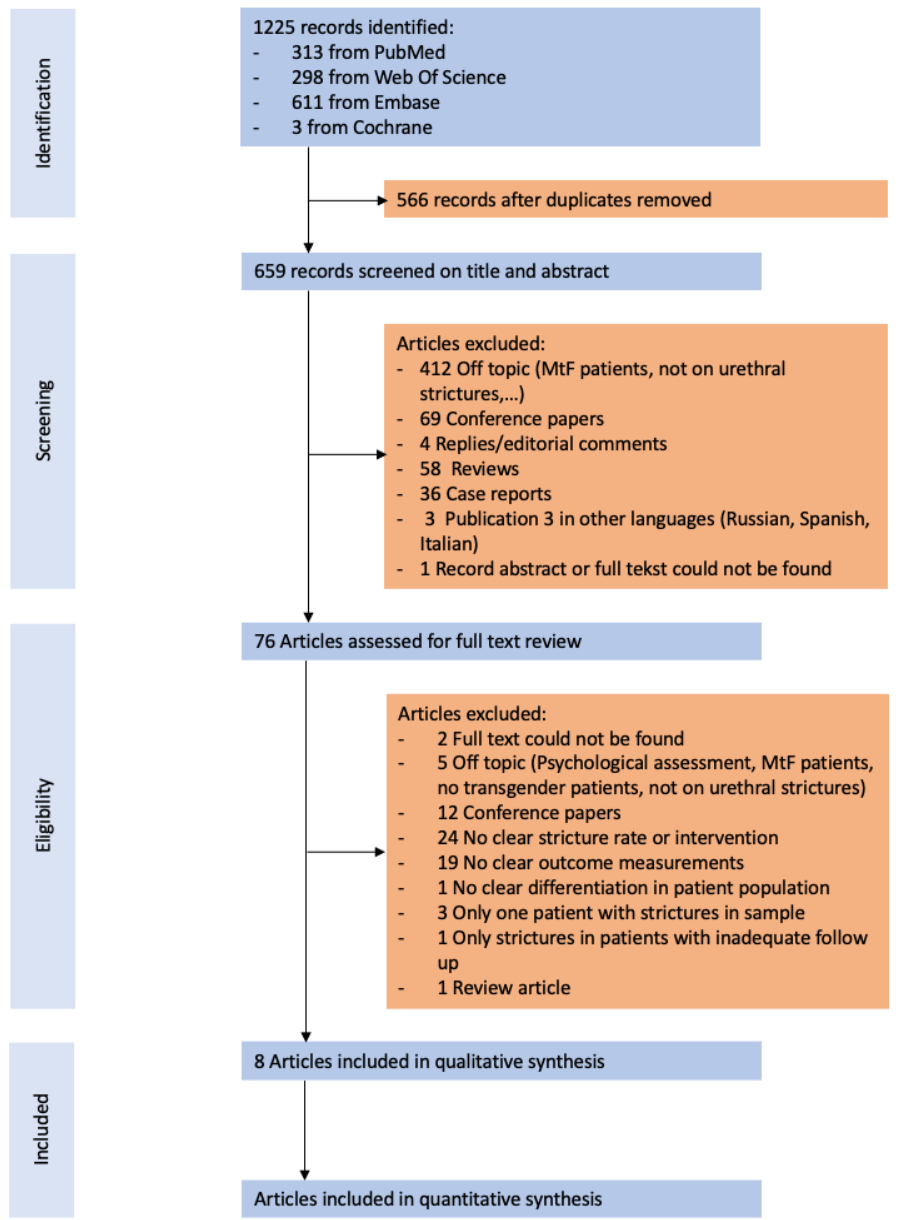
Figure 1. PRISMA flow diagram for study selection. Table 1. Summary characteristics and risk of bias of included studies. FtM (Female to Male), NA (Not Applicable), NR (Not Reported), RFFF (Radial Forearm Free Flap), ALT (Aterolateral Thigh flap), SCIAP (Superfical Circumflex Iliac Artery flap), IQR (Inter Quartile Range).